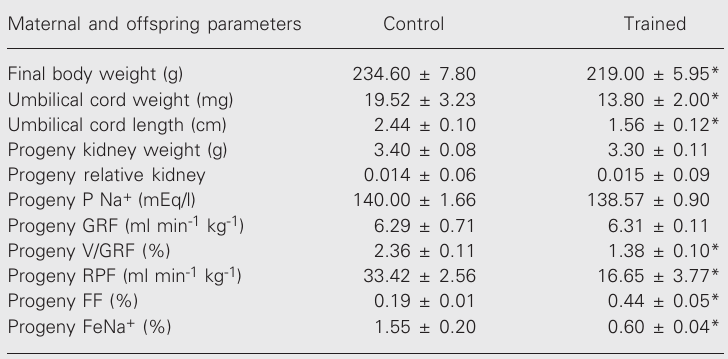
Data are reported as means ± SD for 7 animals per group. FeNa + = fraction of urinary sodium excretion; FF = filtration fraction; GRF = glomerular filtration rate; P Na + = plasma sodium concentration; RPF = renal plasma flow; V/GFR = urine flow as percentage of glomerular filtration rate. *P < 0.01 compared to control (Student t -